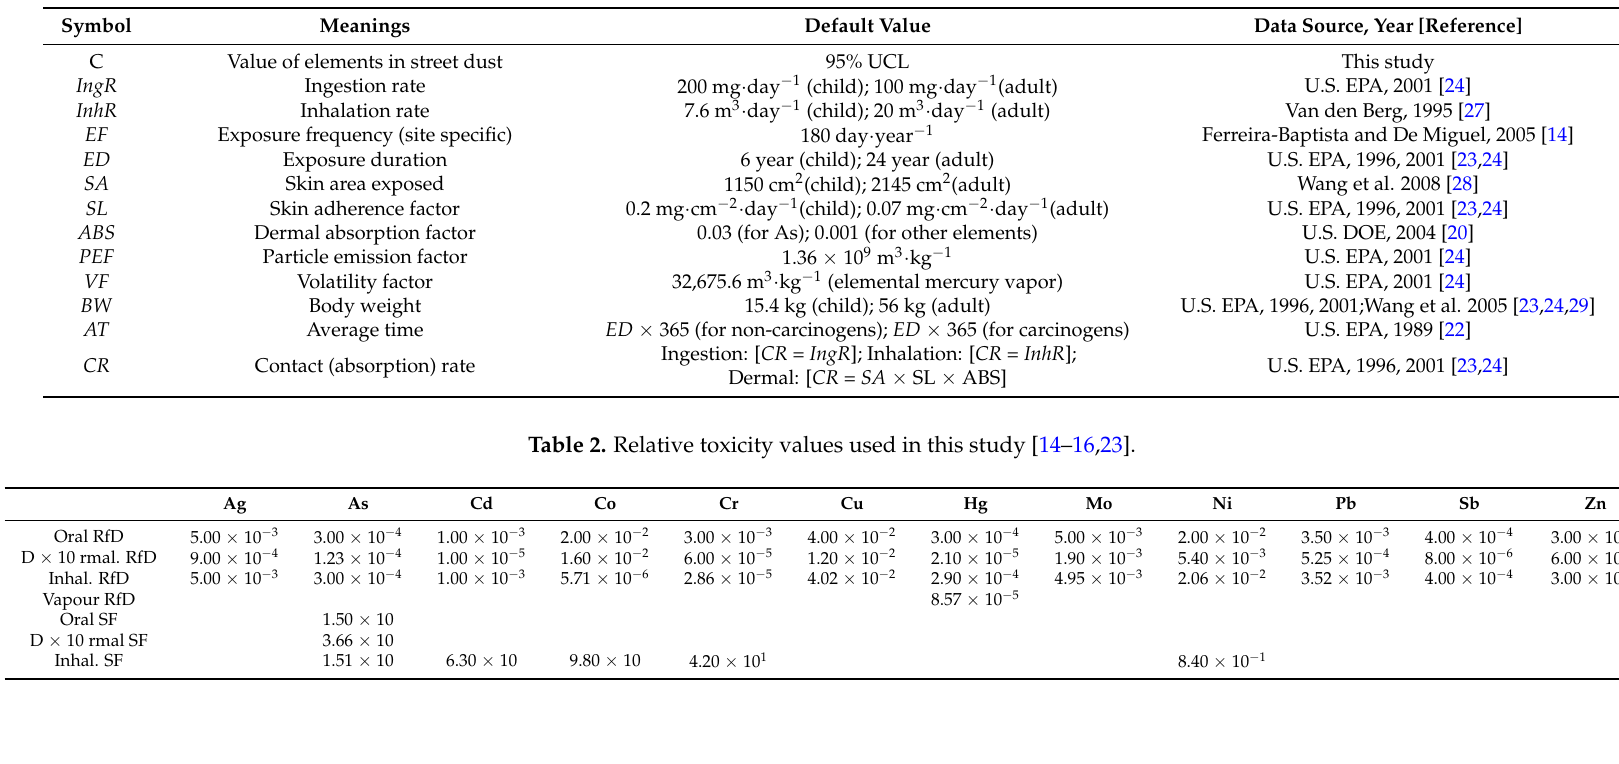
Table 1. Description of parameters and the default values used in does and health risk assessment.